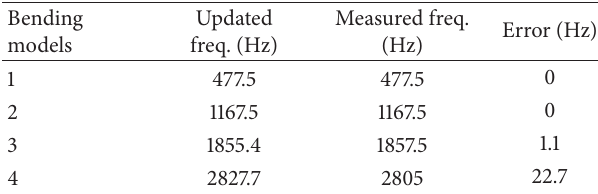
Table 6: Comparison for modal frequencies.